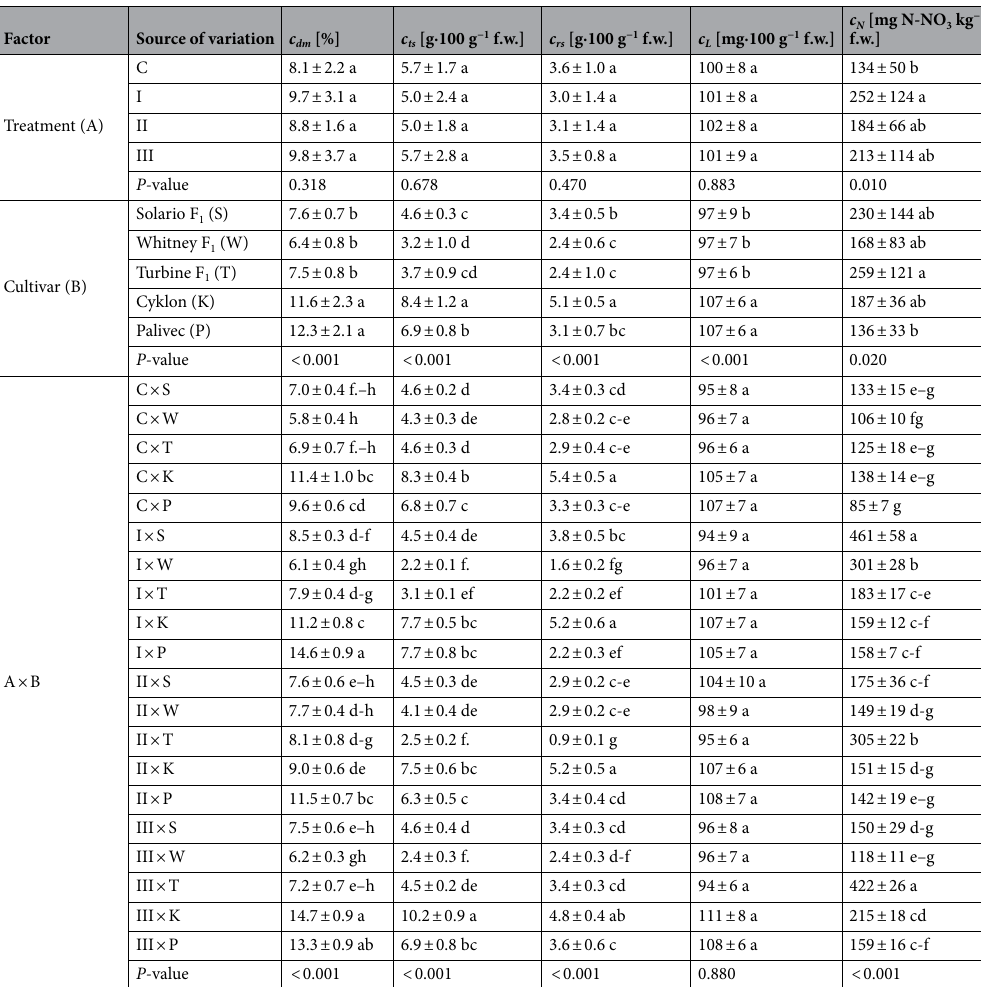
Table 4. Effect of the combined application of biostimulants on the chemical composition (mean values ± standard deviations) of fruit in the analyzed cultivars of Capsicum annuum . Means followed by different letters are significantly different for each parameter (the level of significance, the p -value, is shown in the table). c dm -dry matter content, c ts -total sugar content, c rs -reducing sugar content, c L –L-ascorbic acid content, c N -nitrate (V) content. C-control treatment; I-BB Foliar + Multical; II-BB Foliar + Multical + MK5; III-BB Foliar + Multical + MK5 + Biocin